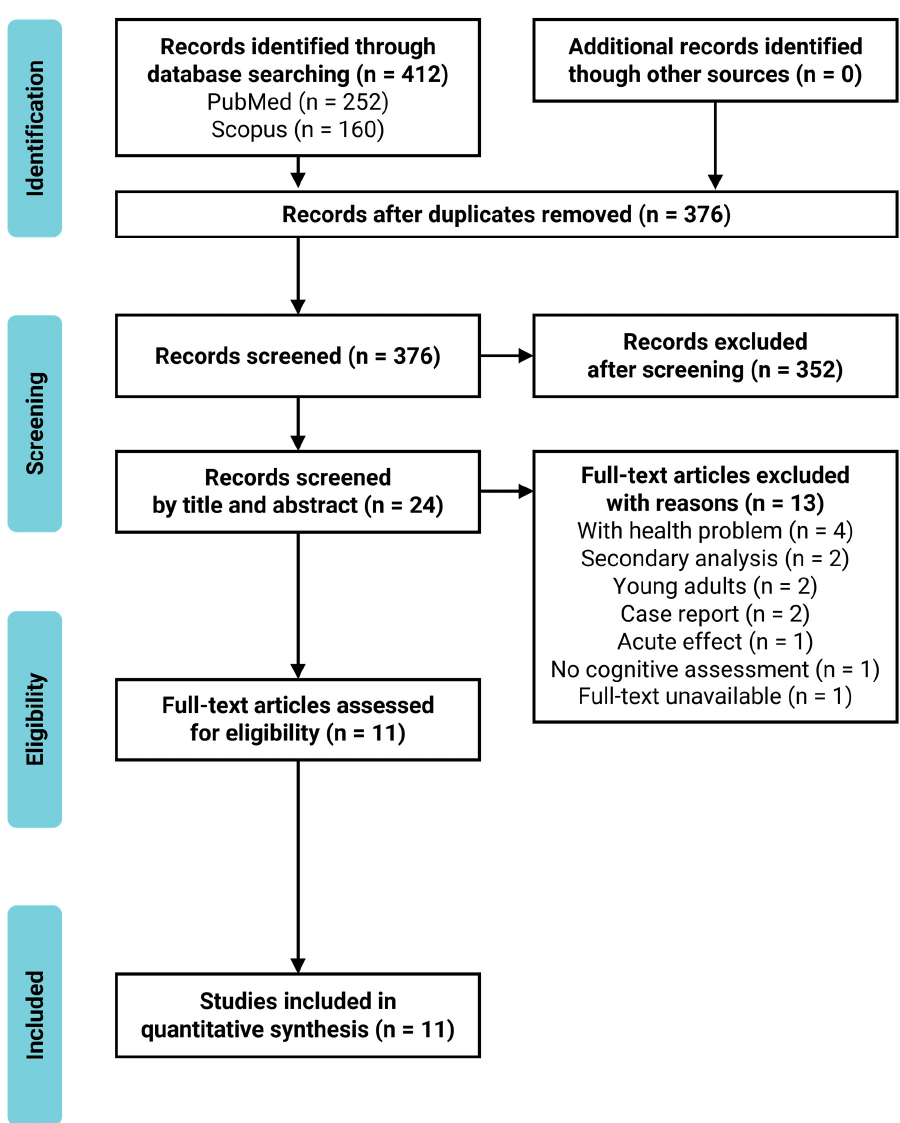
Figure 1. PRISMA flowchart.